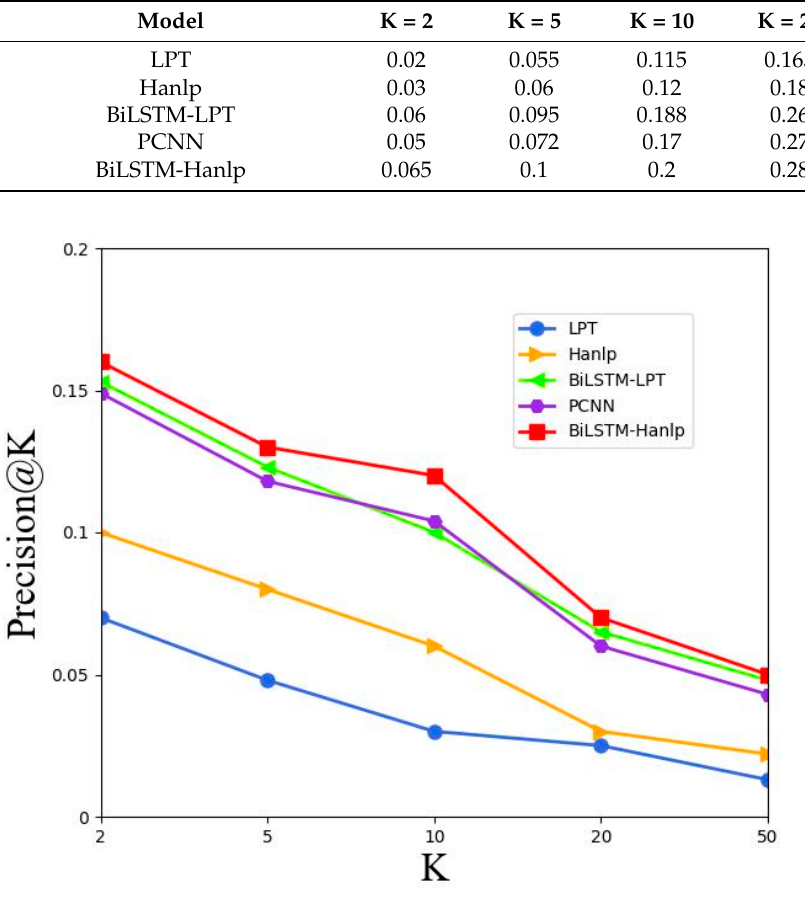
Figure 6. Named entity recognition results based on Precision@K.